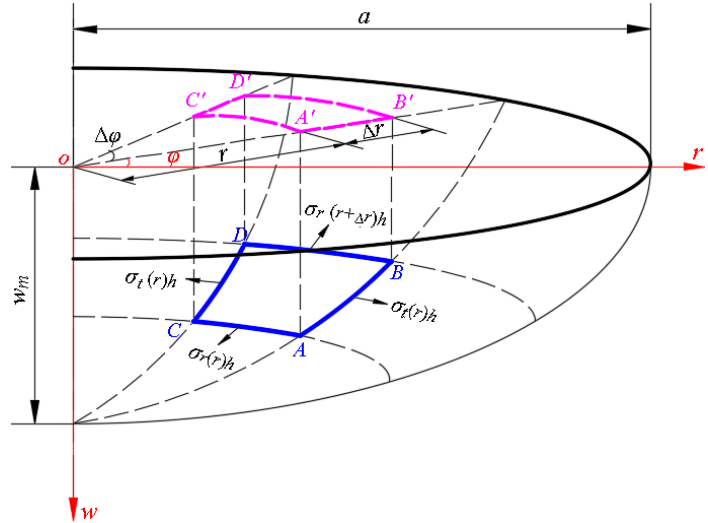
Figure A1. Diagram of the cylindrical coordinate system and the differential element ABCD .